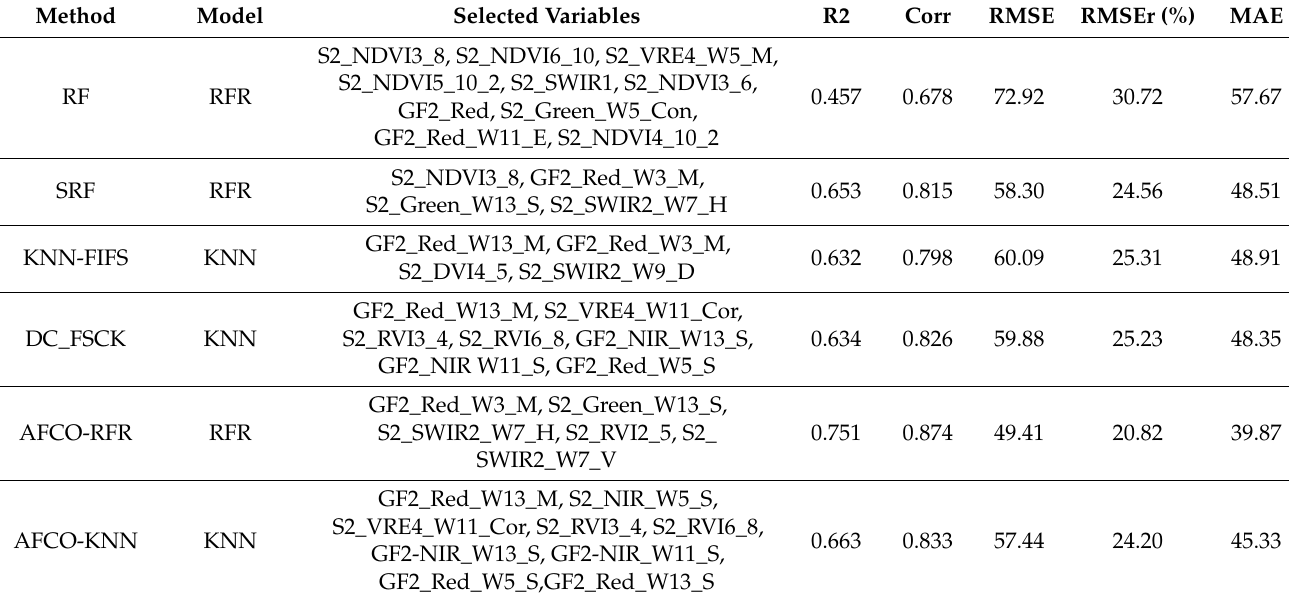
Table 5. Accuracy assessment of GSV estimation (m 3 /ha) based on integrated GF-2 and Sentinel-2 (S2) images data from the RFR or KNN models with various feature variables selected by the RF, Scheme 3 × 3, 5 × 5, 7 × 7, 9 × 9, 11 × 11, 13 × 13).